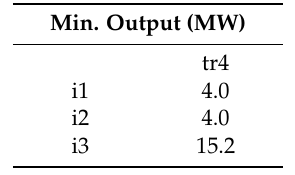
Table A13. Minimum output capacity of unit i (MW): g_min( i